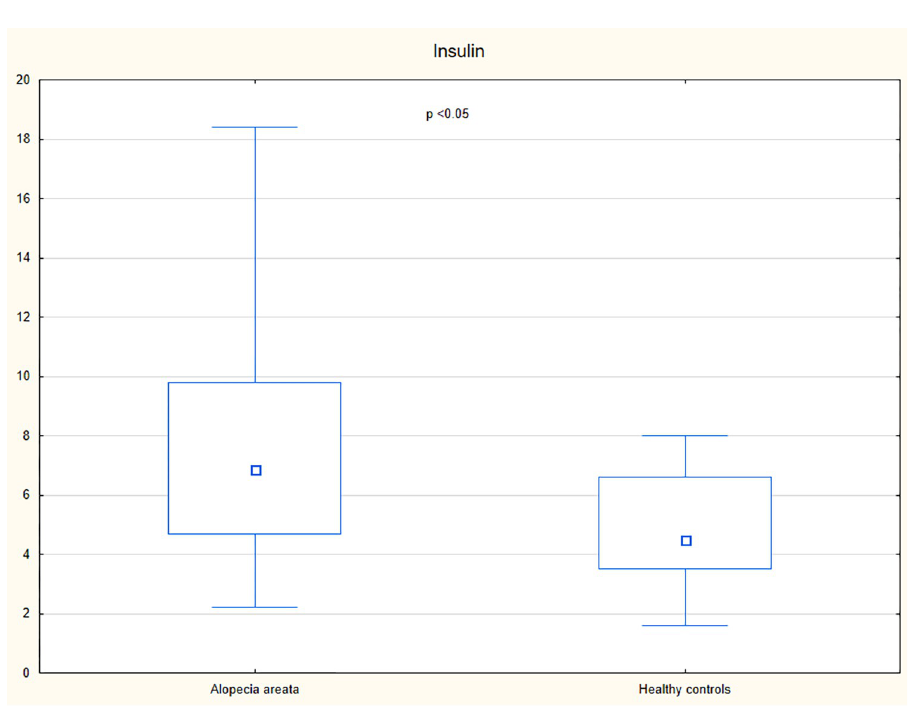
Fig 2. Serum concentrations of insulin in patients with alopecia areata and healthy controls.